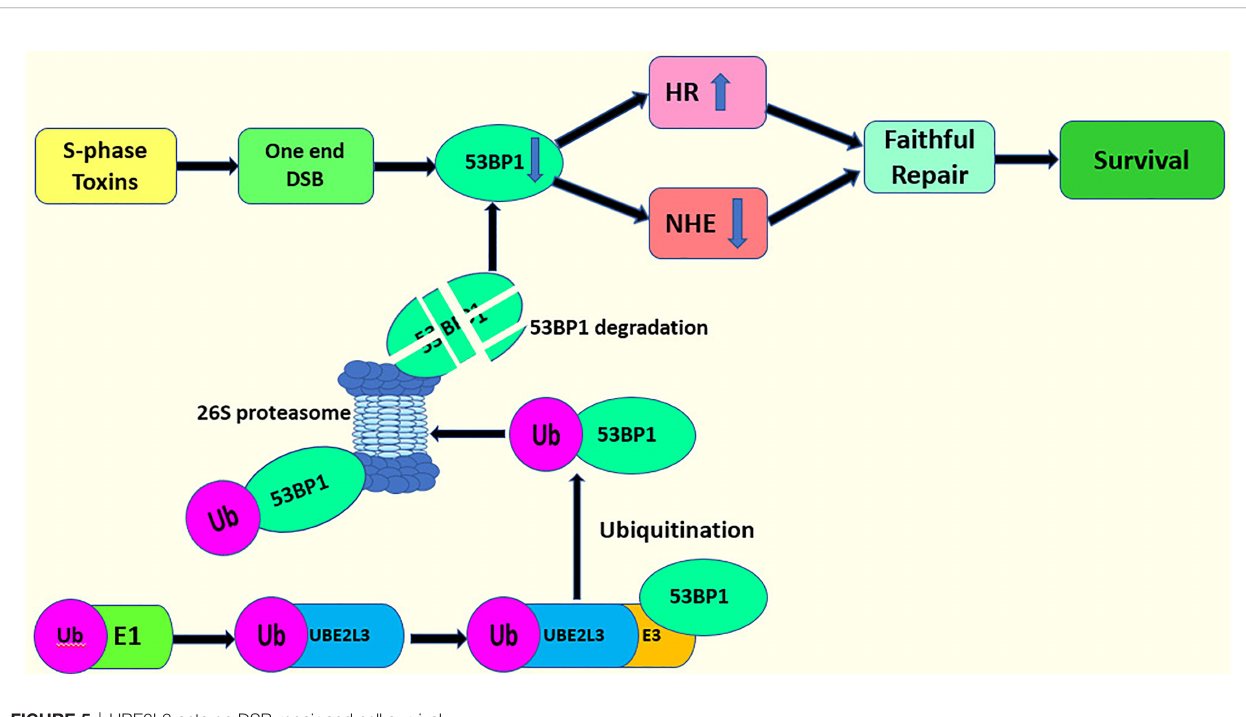
FIGURE 5 | UBE2L3 acts on DSB repair and cell